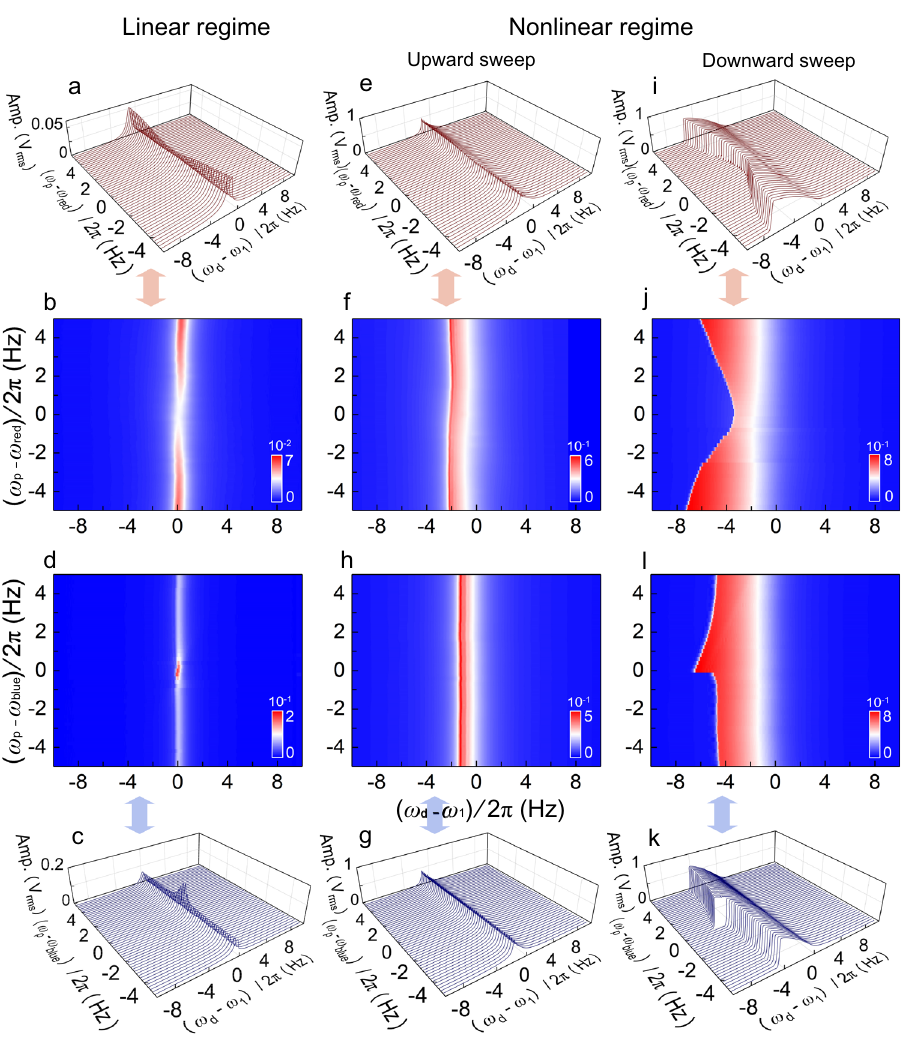
Fig. 2 Linear versus nonlinear responses of the ω 1 resonant mode parametrically coupled to the phonon cavity. a Resonant response of the ω 1 mode in the linear regime under different pump frequency ω p , when pumping near the red sideband ω red of the phonon-cavity. b 2D color plot of the same data as in a ; same hereafter. The 2D color plots allow key features in the frequency domain (along both ω d and ω p ) to be better visualized, and enable ef fi cient comparison to the theory plots in Fig. 3. c , d Resonant response in the linear regime when pumping near the blue sideband ω blue of the phonon-cavity. e – h Nonlinear response of the ω 1 mode with an upward frequency sweep, under different pump frequency ω p near the red sideband ω red ( e , f ) and blue sideband ω blue ( g , h ), respectively. i – l Nonlinear response of the ω 1 mode with a downward frequency sweep, under different pump frequency ω p near the red sideband ω red ( i , j ) and blue sideband ω blue ( k , l ), respectively, showing clear modulation of the bi-stability frequency ω b with distinct patterns. Experimental details are provided in “ Methods ” and SI 1.2, with additional data in SI